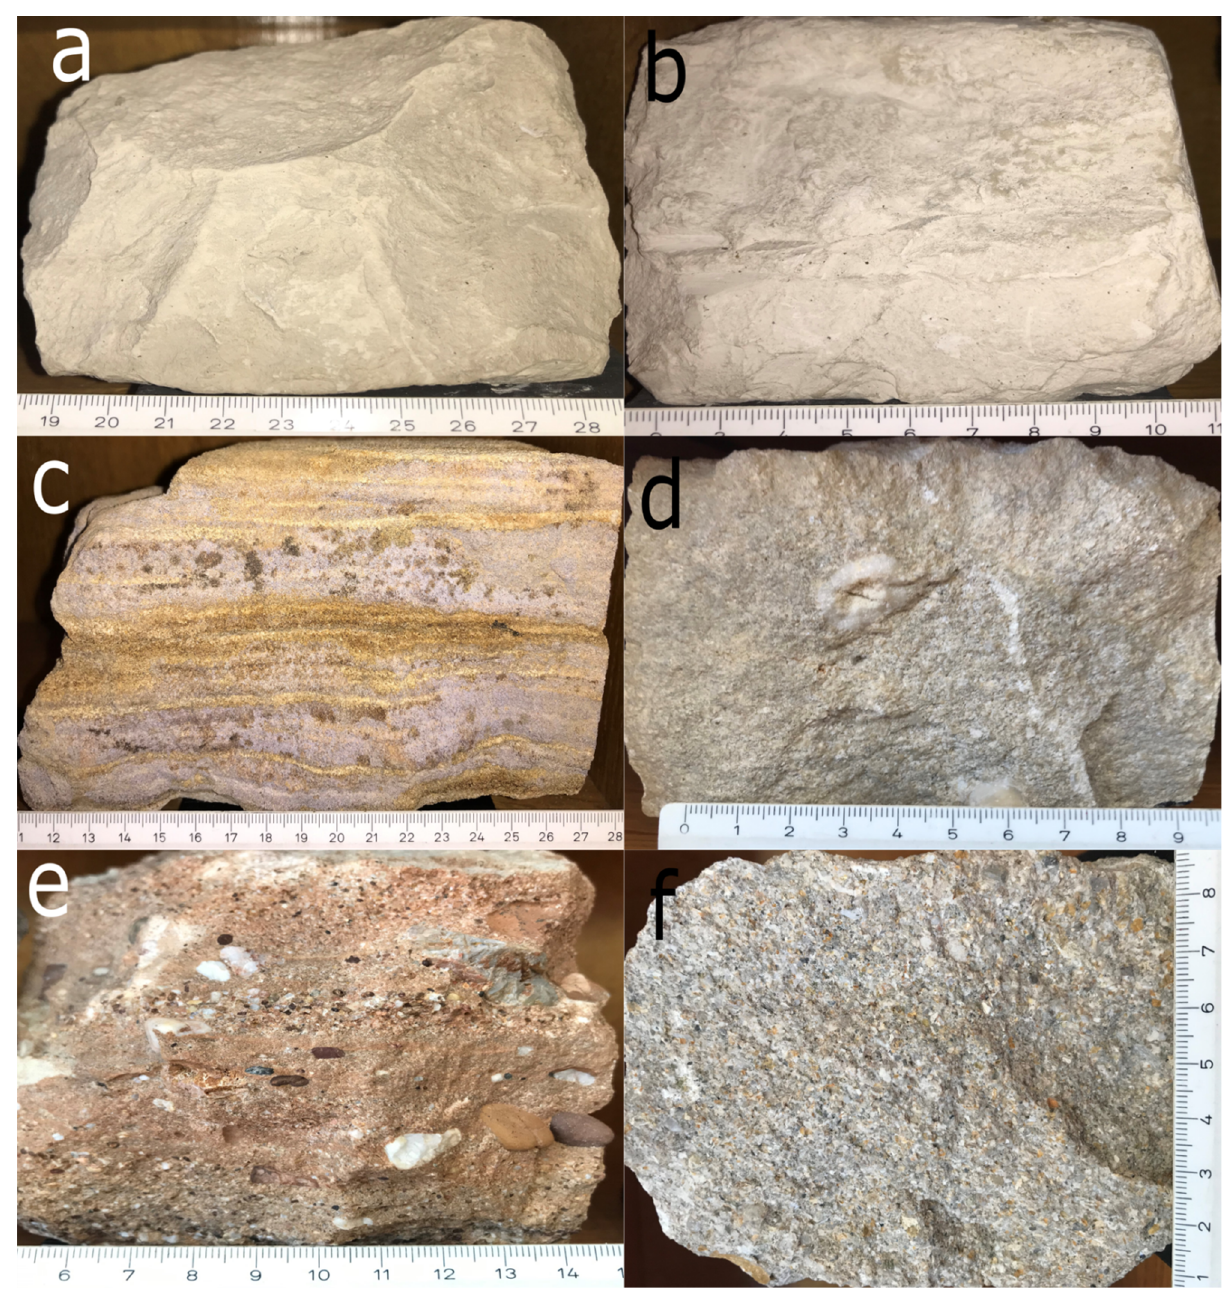
Figure 2. ( a – f ). Specimens of the characteristic Middle and Upper Miocene sedimentary rocks taken from the surface out- crops: ( a , b )—marls; ( c )—laminated sandstone; ( d )—calcarenitic sandstone; ( e )—interlayered conglomerate and sandstone; ( f )—coarse-grained calcarenitic sandstone to fine-grained conglomerate. Samples are taken from the surface, at localities: SW Medvednica Mt. ( a , d , e ); SE Medvednica Mt. ( b ); Jerovec ( c ); Brezniˇcki Hum ( f ); all at the western margin of the CPBS. All samples are from the referent and demonstrational Minerals and Rocks Collection, situated at the Department of Mineralogy, Petrology and Mineral Resources (Faculty of Mining, Geology and Petroleum Engineering, University of Zagreb).